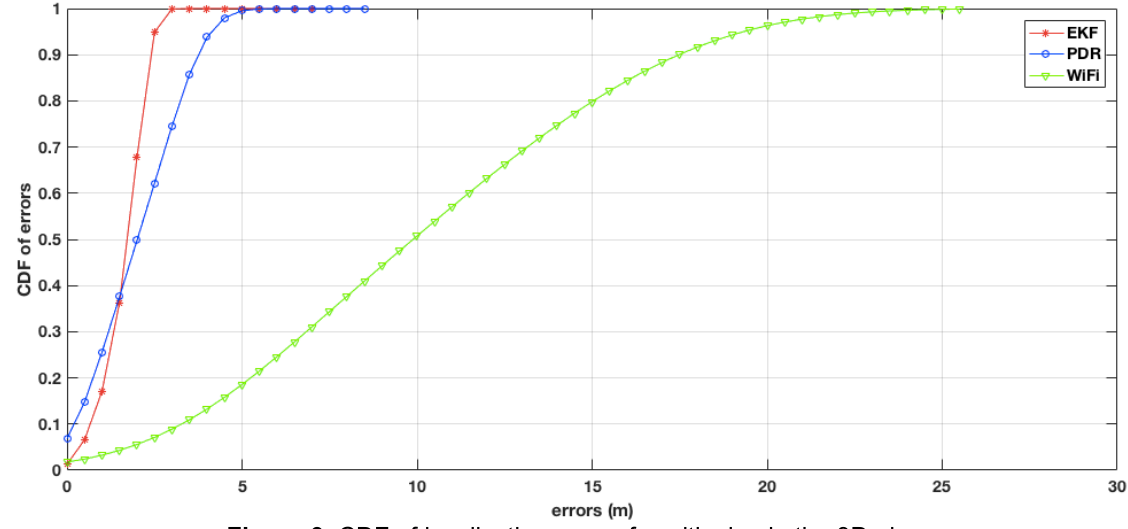
Figure 9. CDF of localization error of positioning in the 3D plan